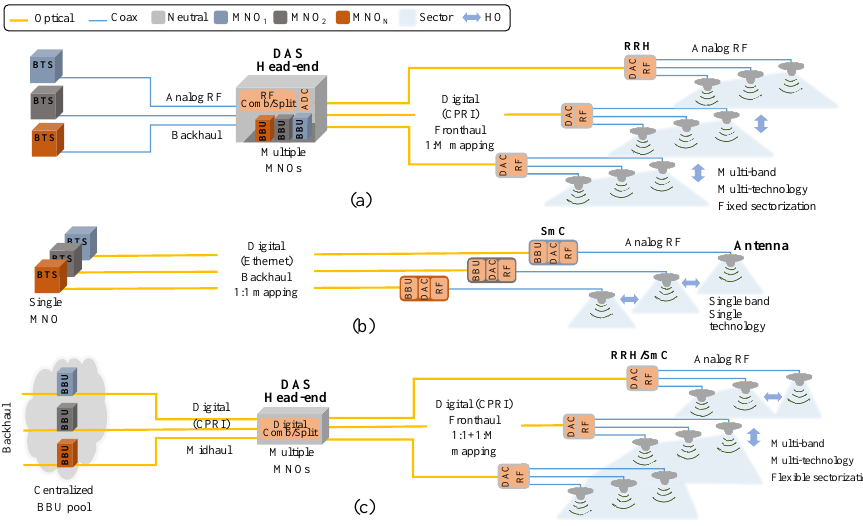
Figure 1. Illustration of ( a ) digital DAS, ( b ) typical SmC, and ( c ) C-RAN-based integration of DAS and SmC in the context of 5GB